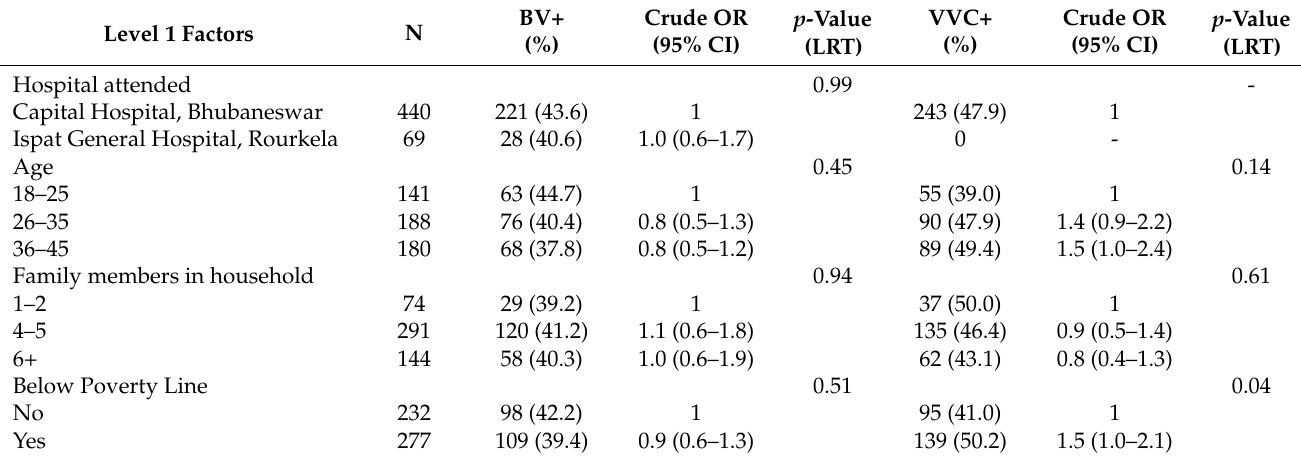
Table 1. Crude odds ratios for BV and VVC according to socio-demographic factors (N = 509). Level 1